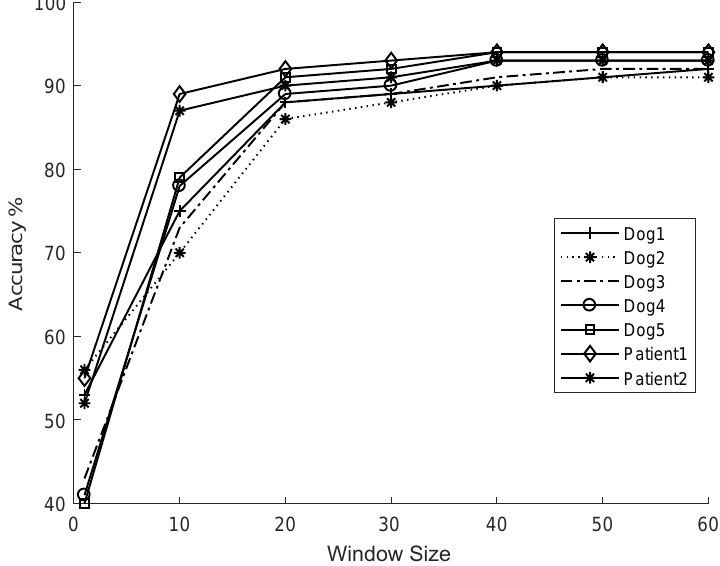
Figure 6. Accuracy ( A ) of a linear Support Vector Machine classifier as a function of window